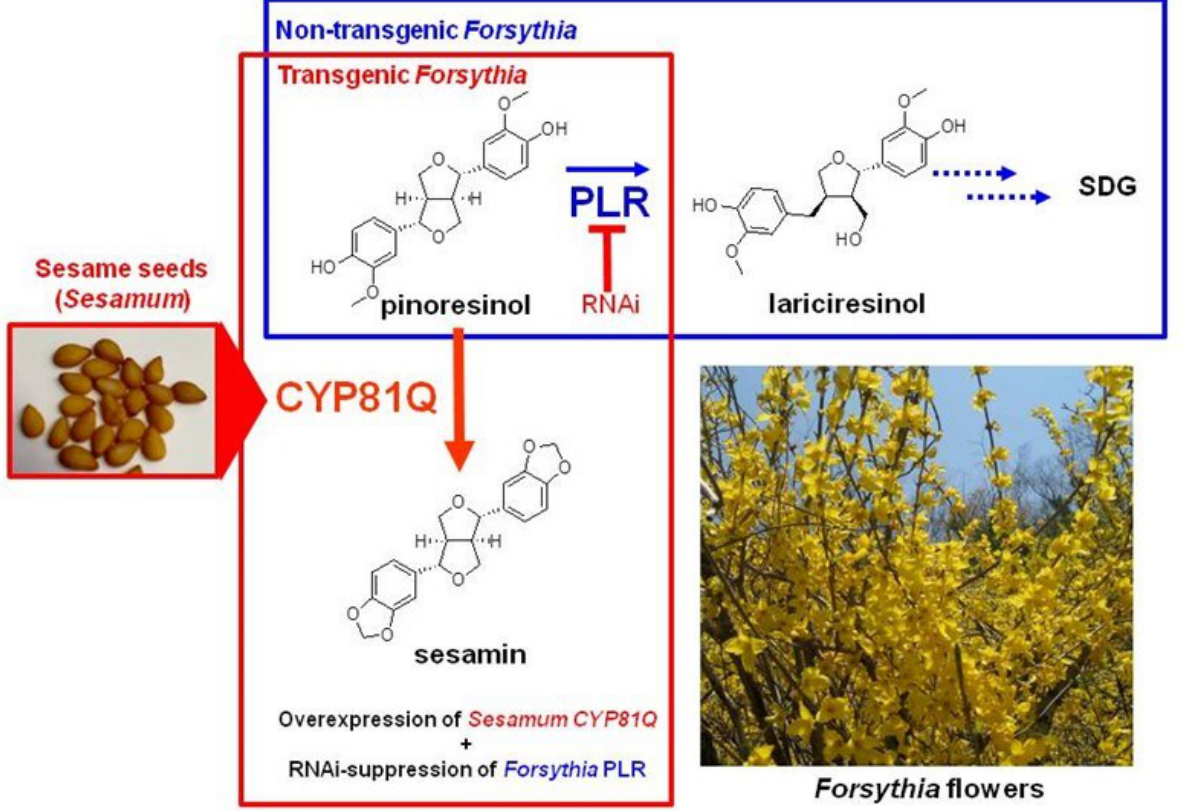
Figure 3. Metabolic Engineering of Forsythia Suspension Cell Cultures. The Transgenic Forsythia Suspension Cell Culture, CPi-Fk cells, Acquired the Ability to Produce Sesamin by Stable Transfection of PLR -RNAi and the Sesamum CYP81Q1